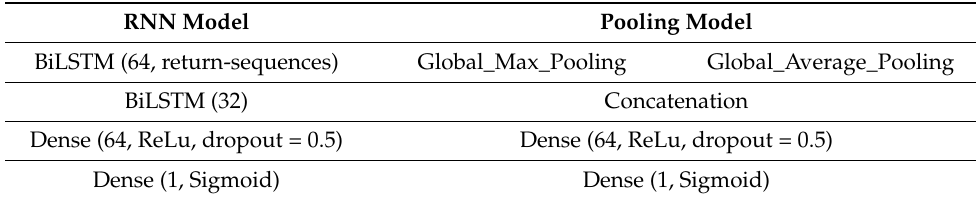
Table 3. The architectures of the RNN model and the pooling